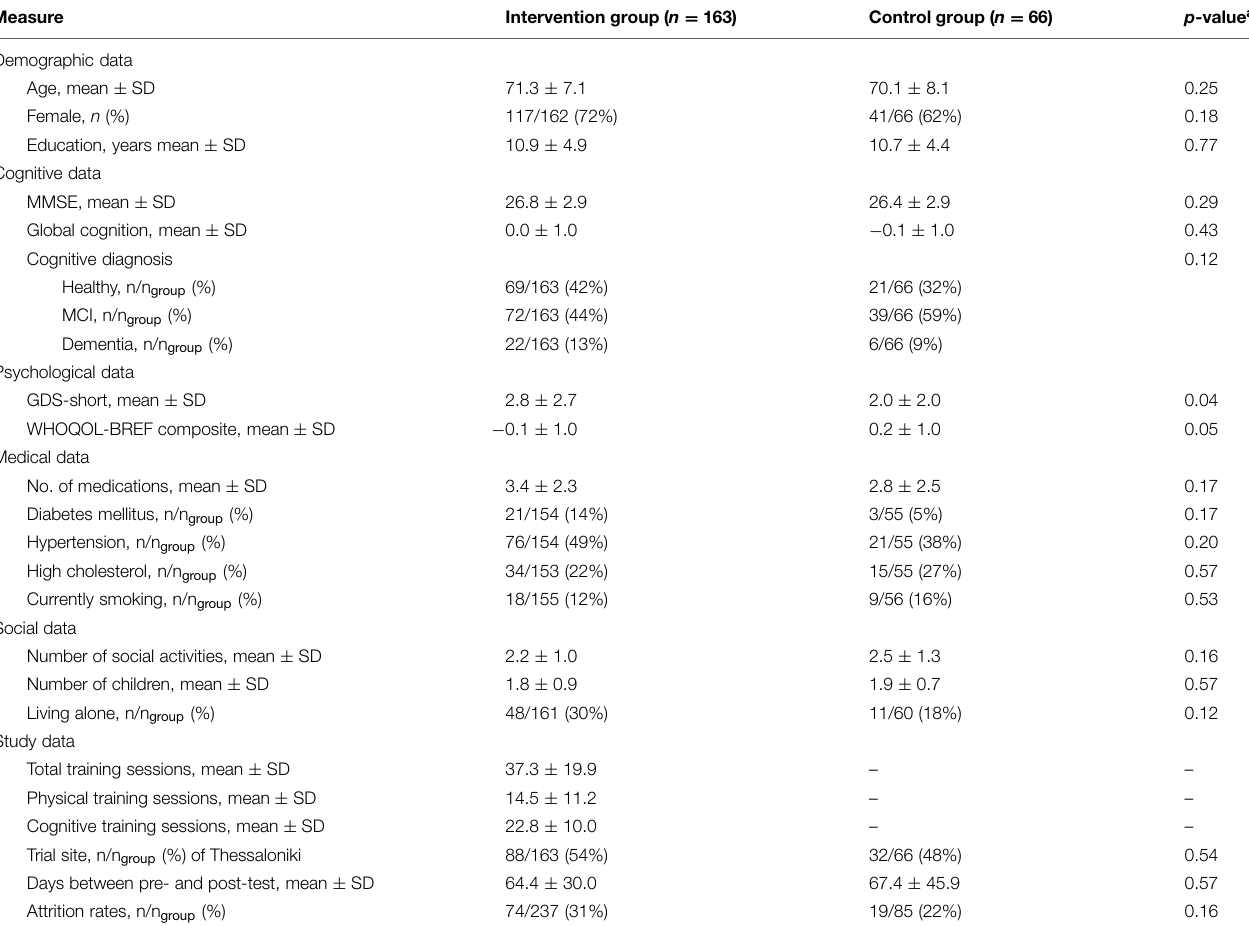
TABLE 1 | Baseline characteristics of intervention group and passive control